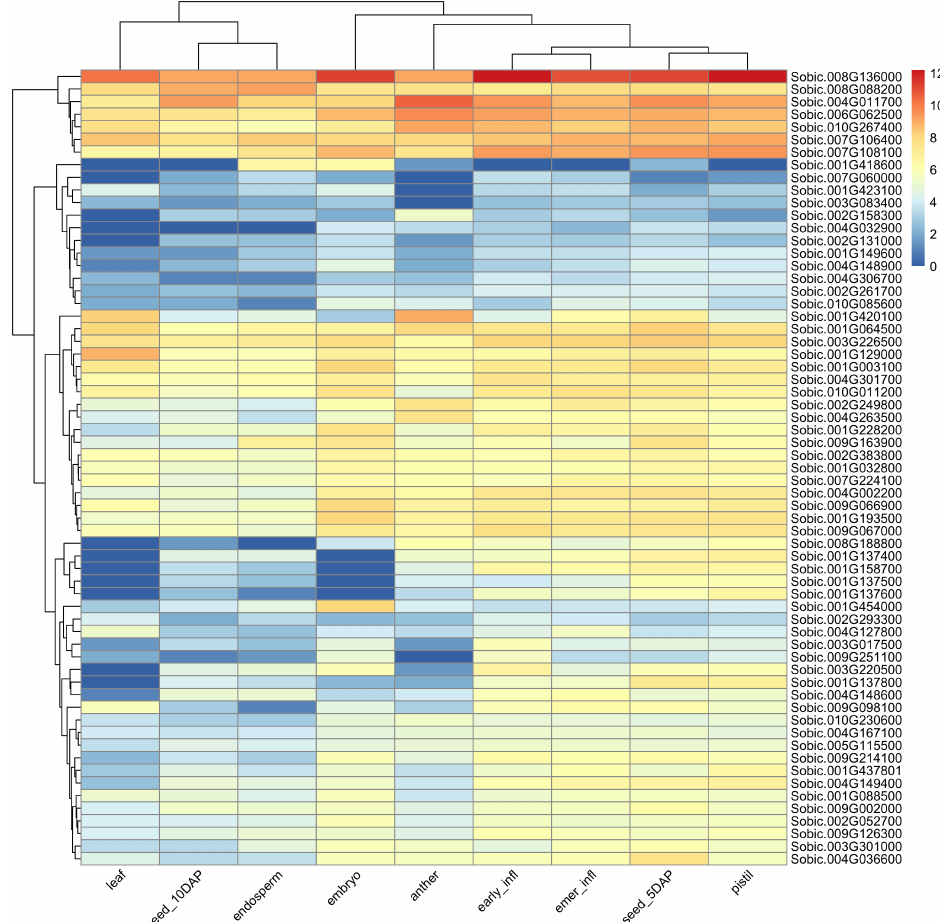
Figure 4. Heatmap showing gene expression analysis of interactors of heat shock 90-6 gene: each row represents a gene, the column corresponds to tissue type, and trees on the left and top show hierarchical clustering of the row and column, respectively. Values in legends correspond to log 2 of transcript per million (TPM). infl: infloresence, emer: post-emergence, DAP: days after